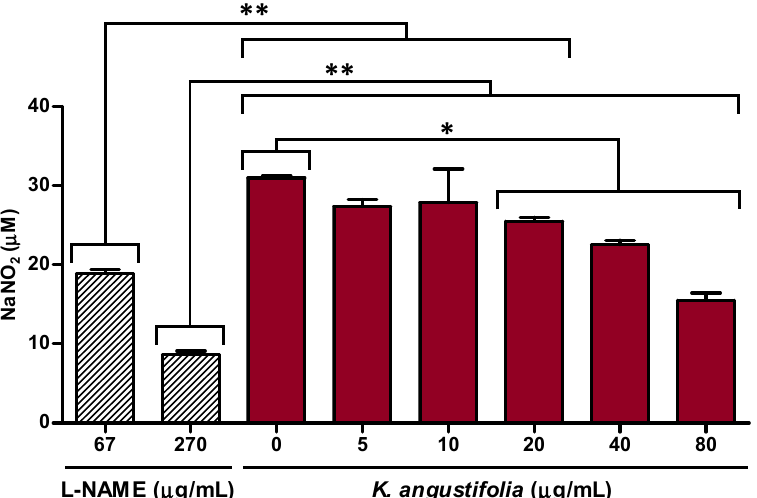
Figure 3. K. angustifolia extract inhibits NO overproduction in LPS-stimulated RAW 264.7 macrophages. All the experiments were carried out in triplicate and presented results are representative of at least two different experiments ( N = 2, n = 3). Data are presented as means of the triplicates ± S.D. Statistical significance was determined using a one-way ANOVA followed by a Bonferroni’s post hoc test ( p -value < 0.05 compared to controls (L-NAME: 67 and 270 μ g/mL, or K. angustifolia : 0 μ g/mL)), * p -value < 0.05, ** p -value < 0.01. L-NAME ( N - ω -nitro-arginine methyl ester hydrochloride), at 67 μ g/mL (250 μ M) and 270 μ g/mL (1 mM), was used as positive control.